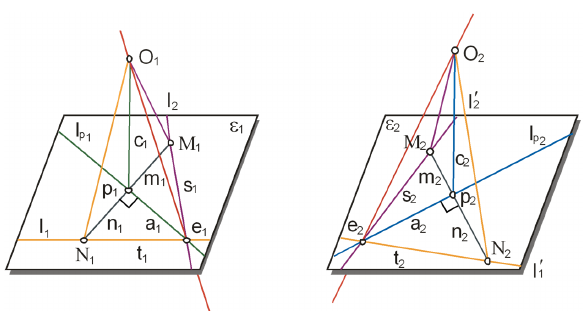
Figure 4. Computation of the dihedral angle γ defined by two epipolar planes ( O 1 e 1 Ν 1 , O 1 e 1 M 1 on the left image and O 2 e 2 Ν 2 , O 2 e 2 M 2 on the